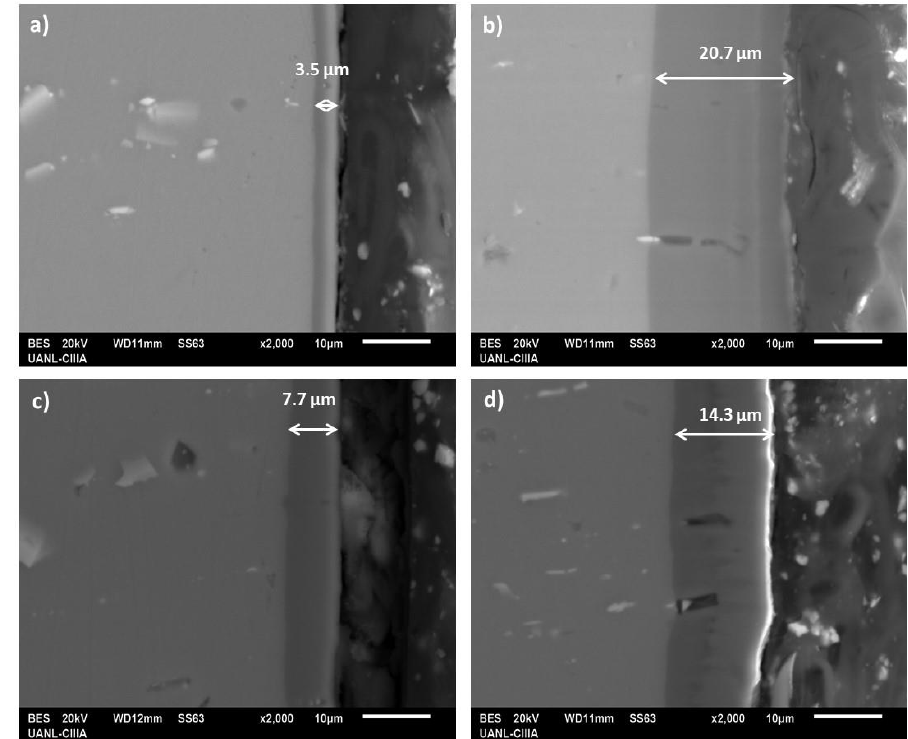
Figure 5. SEM cross-sectional micrographs of the samples anodized in sulfuric acid solution and citric–sulfuric acid solution. ( a ) SA (sulfuric acid) / 1 A · cm − 2 , ( b ) SA (H 2 SO 4 ) / 7.2 A · cm − 2 , ( c ) CA (citric acid) / 1 A · cm − 2 and ( d ) CA (citric acid) / 7.2 A · cm − 2 .